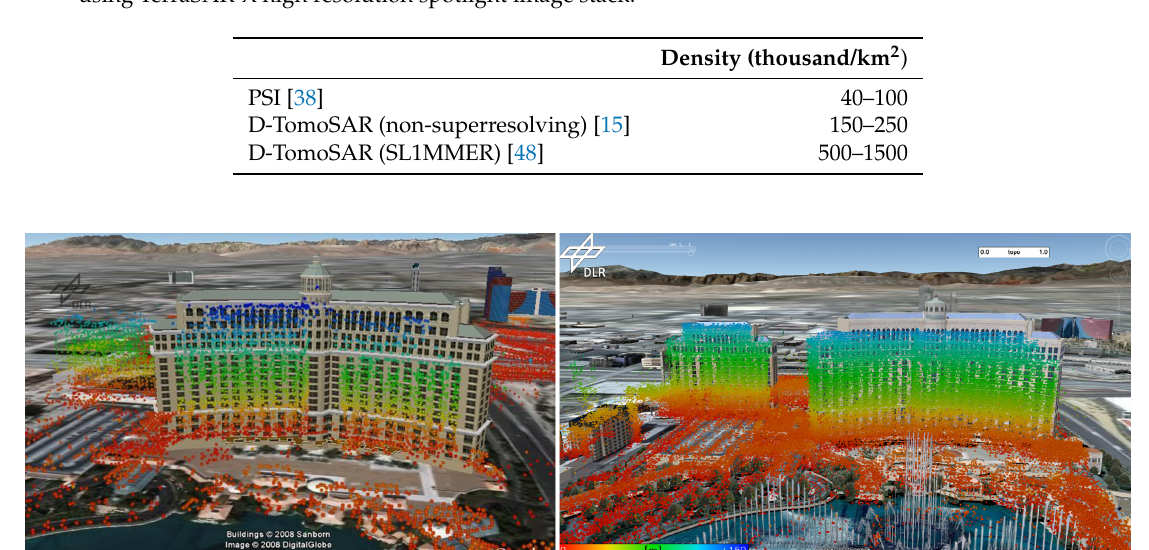
Table 1. Comparison of the typical density of the point cloud reconstructed by PSI and D-TomoSAR using TerraSAR-X high resolution spotlight image stack.